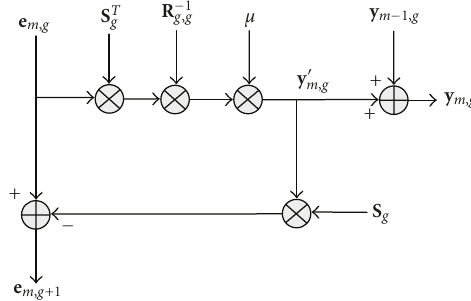
Figure 2: Basic group interference cancellation unit (GICU) for the chip-level linear BSOR-GSIC